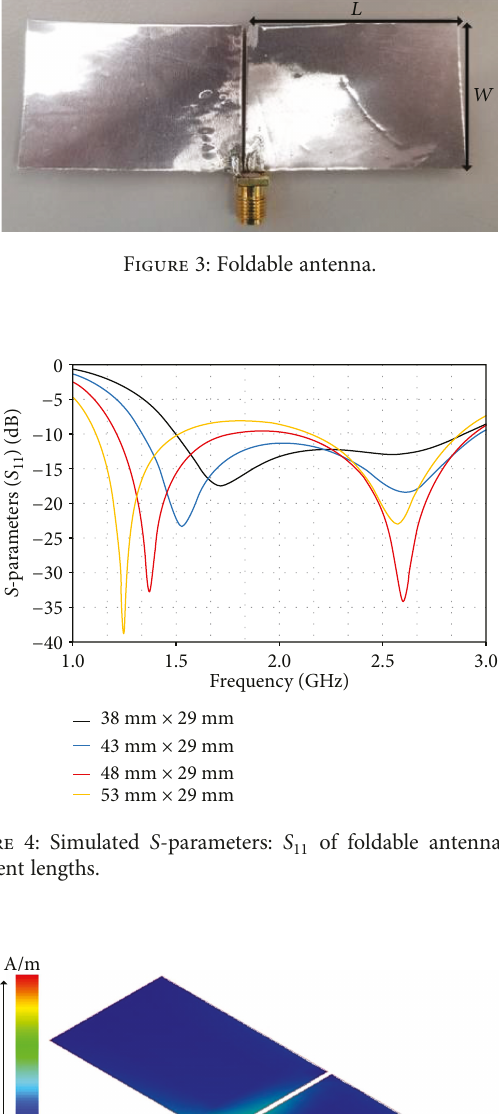
Figure 5: Simulated current distribution ( frequency = 1 5 GHz, with L = 43 mm and W = 29